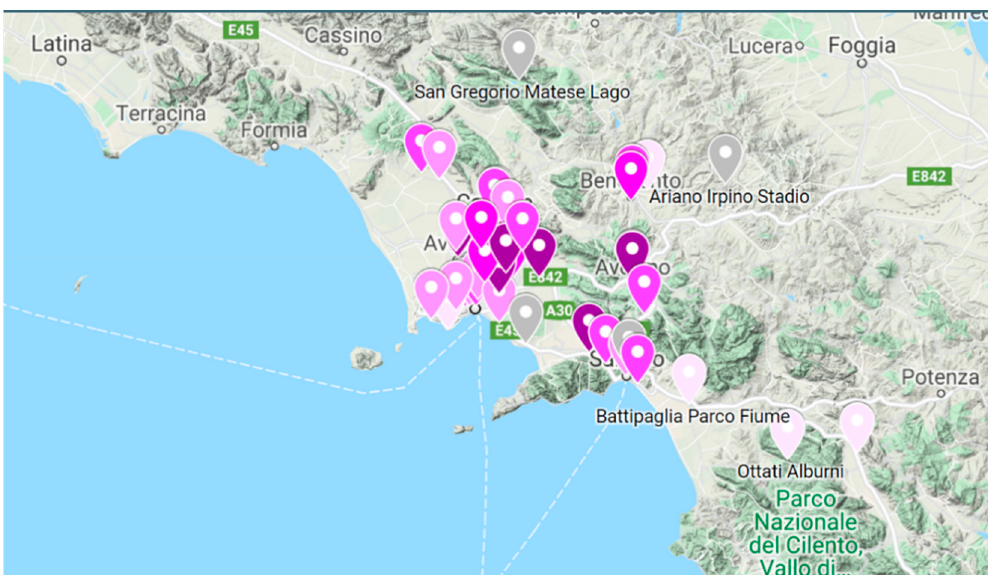
Figure 1. ARPA air quality monitoring network located in the Campania region.